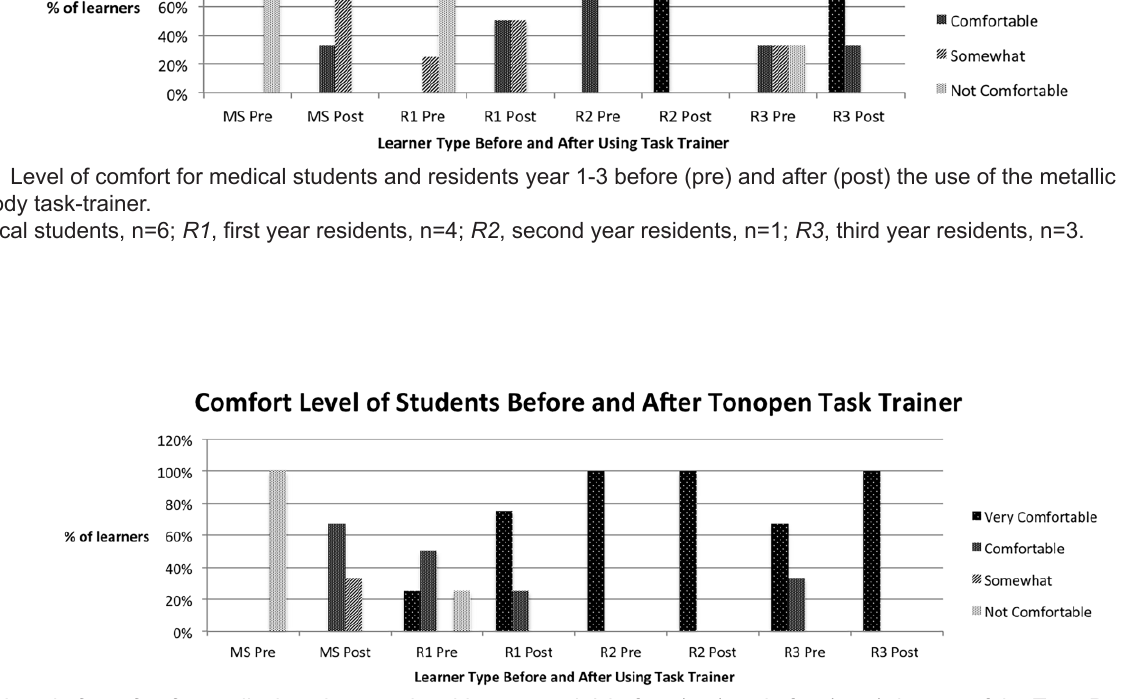
Figure 2. Level of comfort for medical students and residents year 1-3 before (pre) and after (post) the use of the Tono-Pen task-trainer. MS , medical students, n=6; R1 , first year residents, n=4; R2 , second year residents, n=1; R3 , third year residents,